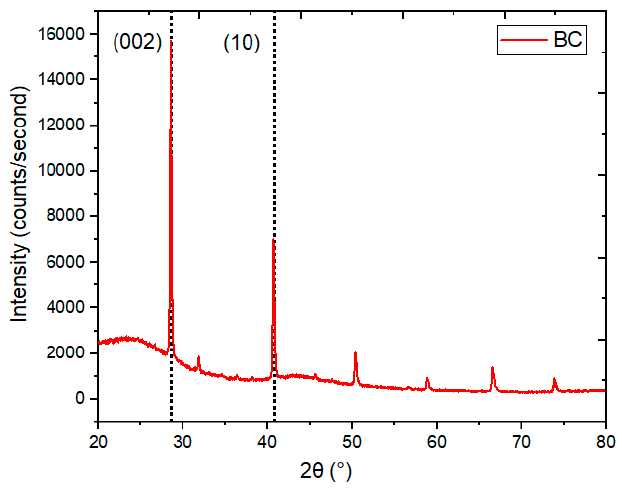
Table 3. Peak position (°) of BC on the 2 θ scale, as determined from the XRD pattern.